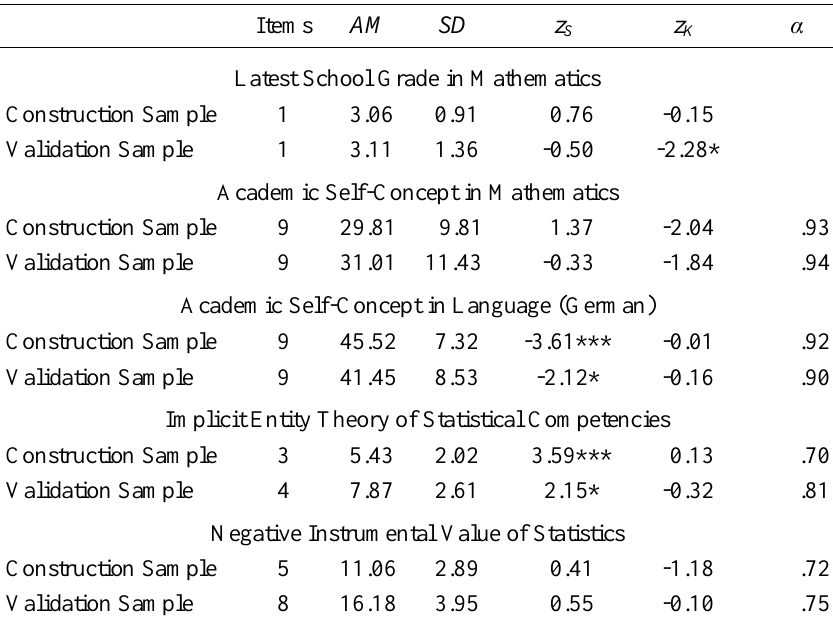
Descriptive statistics and reliabilities of the scales for measuring validation variab-